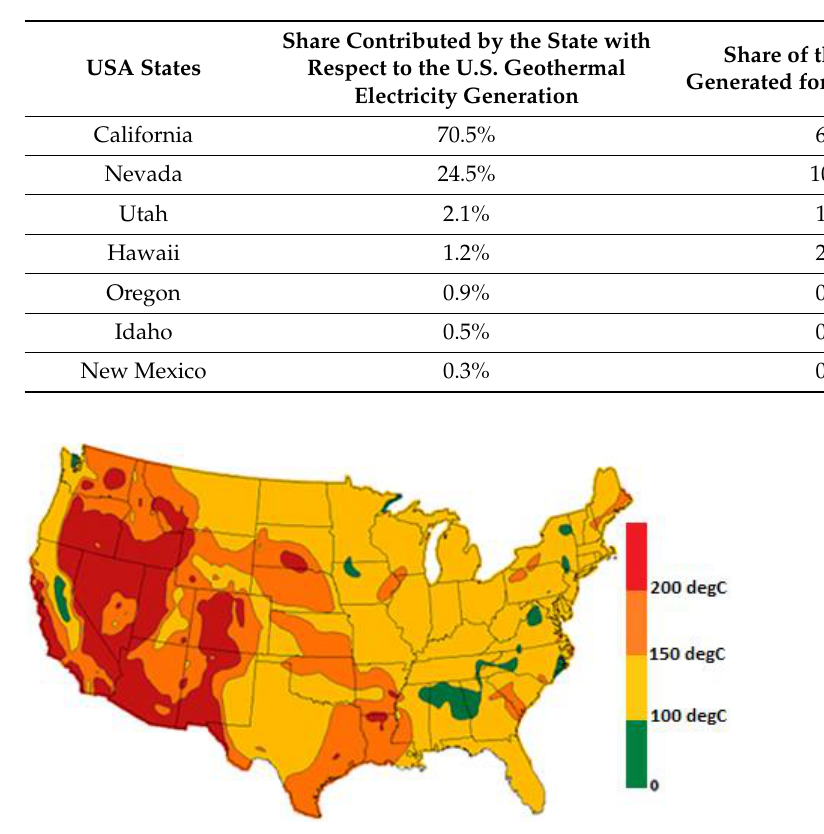
Table 2. Share of the electricity generated from geothermal energy by different states of the USA in 2020 [35].